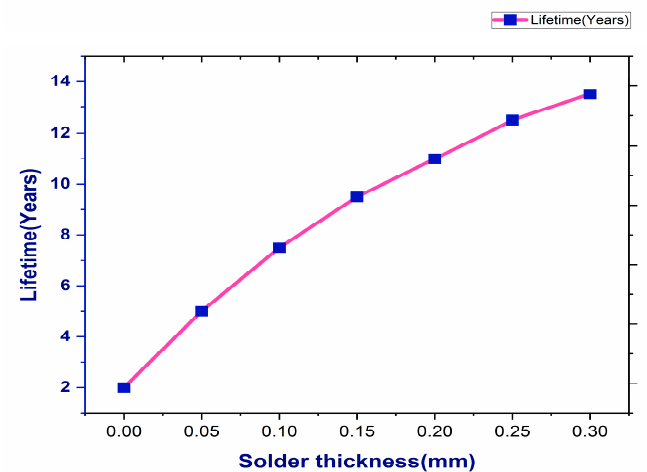
Figure 18. The impact of solder thickness on an IGBT module’s lifespan.